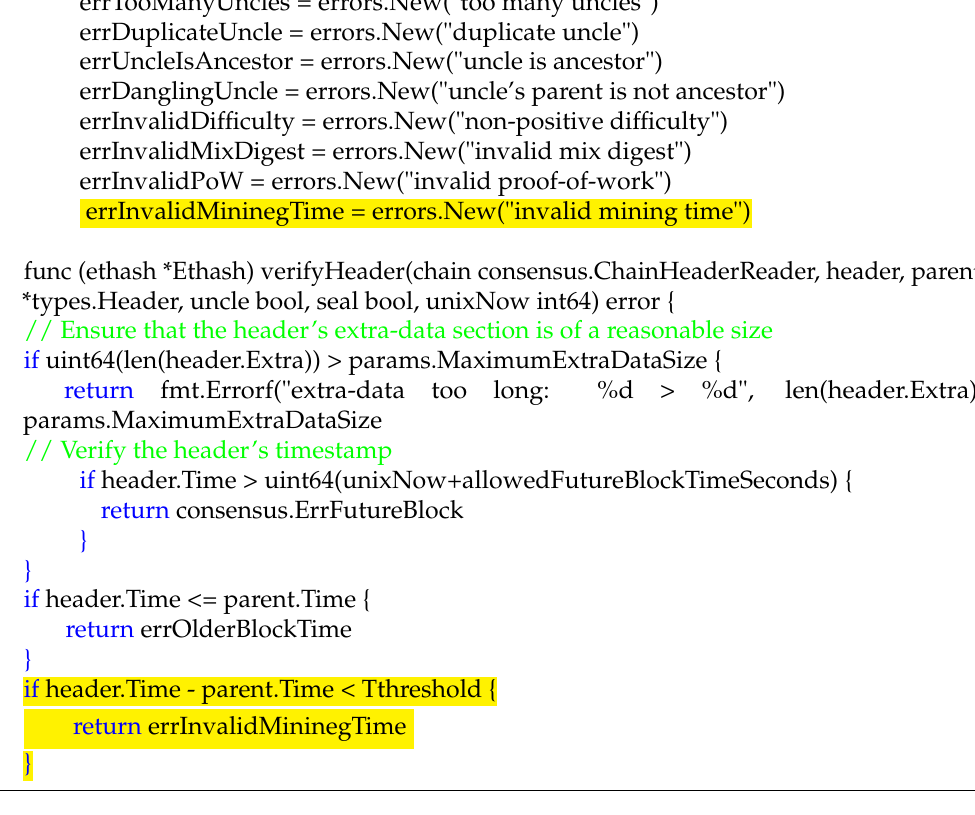
Algorithm 15 Modifications performed on PoW consensus in